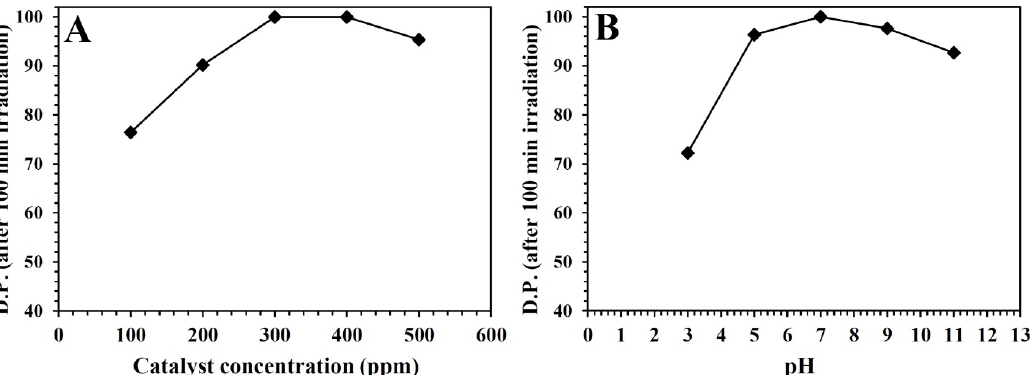
Fig.7. Degradation percentage (D.P.) of Nitenpyram insecticide over the TiO (A) catalyst concentration (pH =7) and (B) pH of the reaction solution (catalyst concentration=300 adjusting the reaction solution pH, aqueous solutions of HCl (0.01M) and NaOH (0.01M) were used. Therefore, the optimized reaction conditions are pH=7 and photocatalyst concentration=300 ppm.